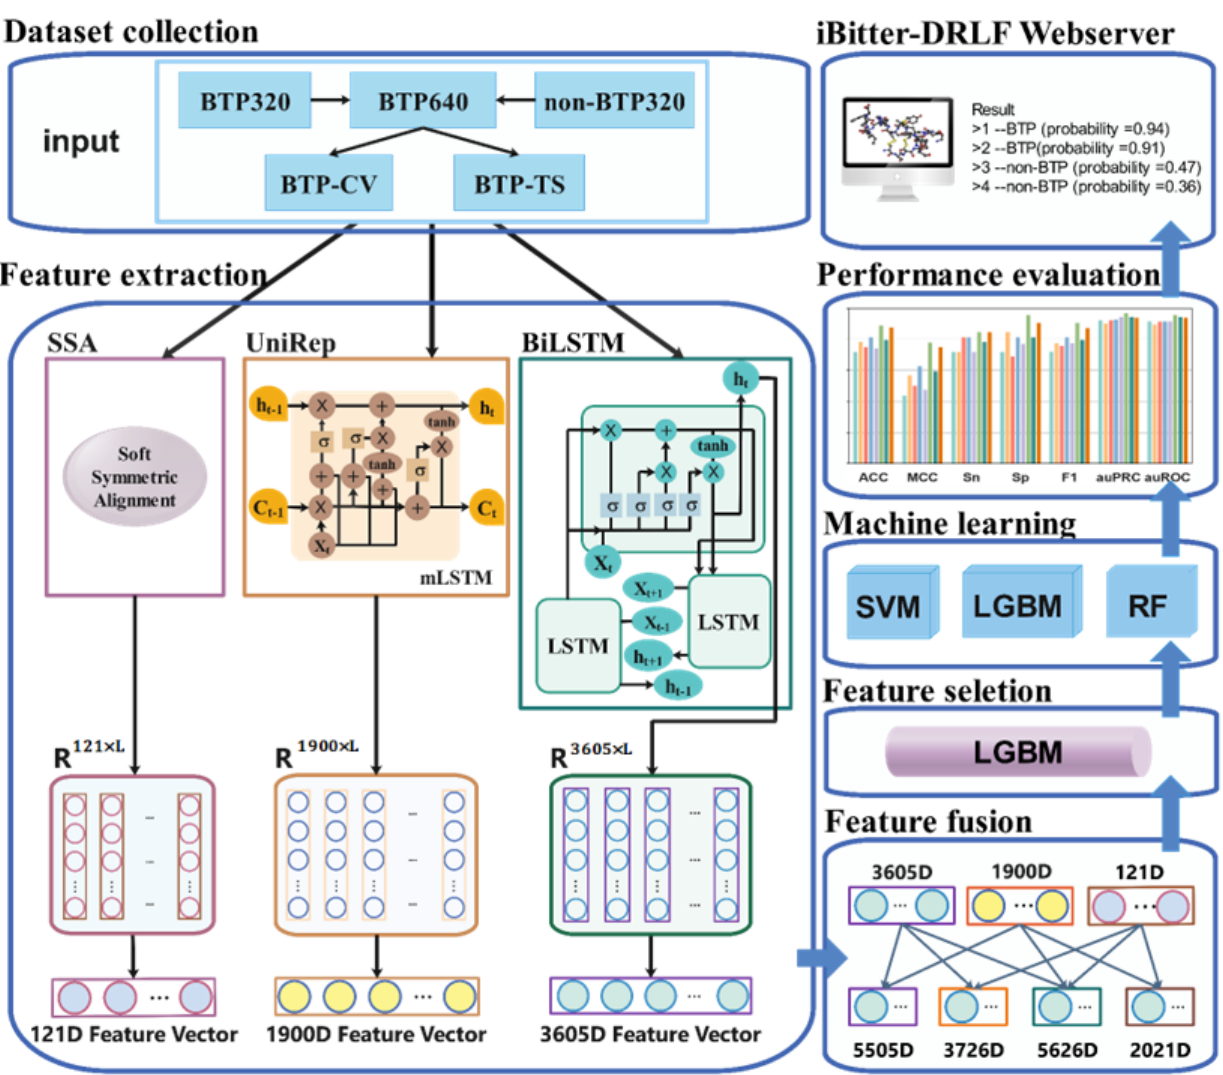
Figure 1. Overview of model development. The pre-trained SSA sequence embedding model, UniRep sequence embedding model, and BiLSTM sequence embedding model were used to embed peptide sequences into eigenvectors. Peptide sequences were converted into 121-dimensional (D) SSA eigenvectors, 1900-dimensional UniRep eigenvectors, and 3605-dimensional (D) BiLSTM eigenvectors. Features were combined and fused to derive the following fusion features: SSA-UniRep (2021D), SSA-BiLSTM (3726D), UniRep-BiLSTM (5505D), and SSA-UniRep-BiLSTM (5626D). These fusion features were used as inputs to the SVM, RF, and LGBM predictor algorithms. The model was optimized by feature selection using the LGBM method. Selected feature sets were subjected to another round of analysis using three algorithms and various hyperparameters. Through 10-fold cross-validation and comparison of independent tests results, the optimized final model was developed. Here, the example like SSA-BiLSTM means two kind of features are combined.